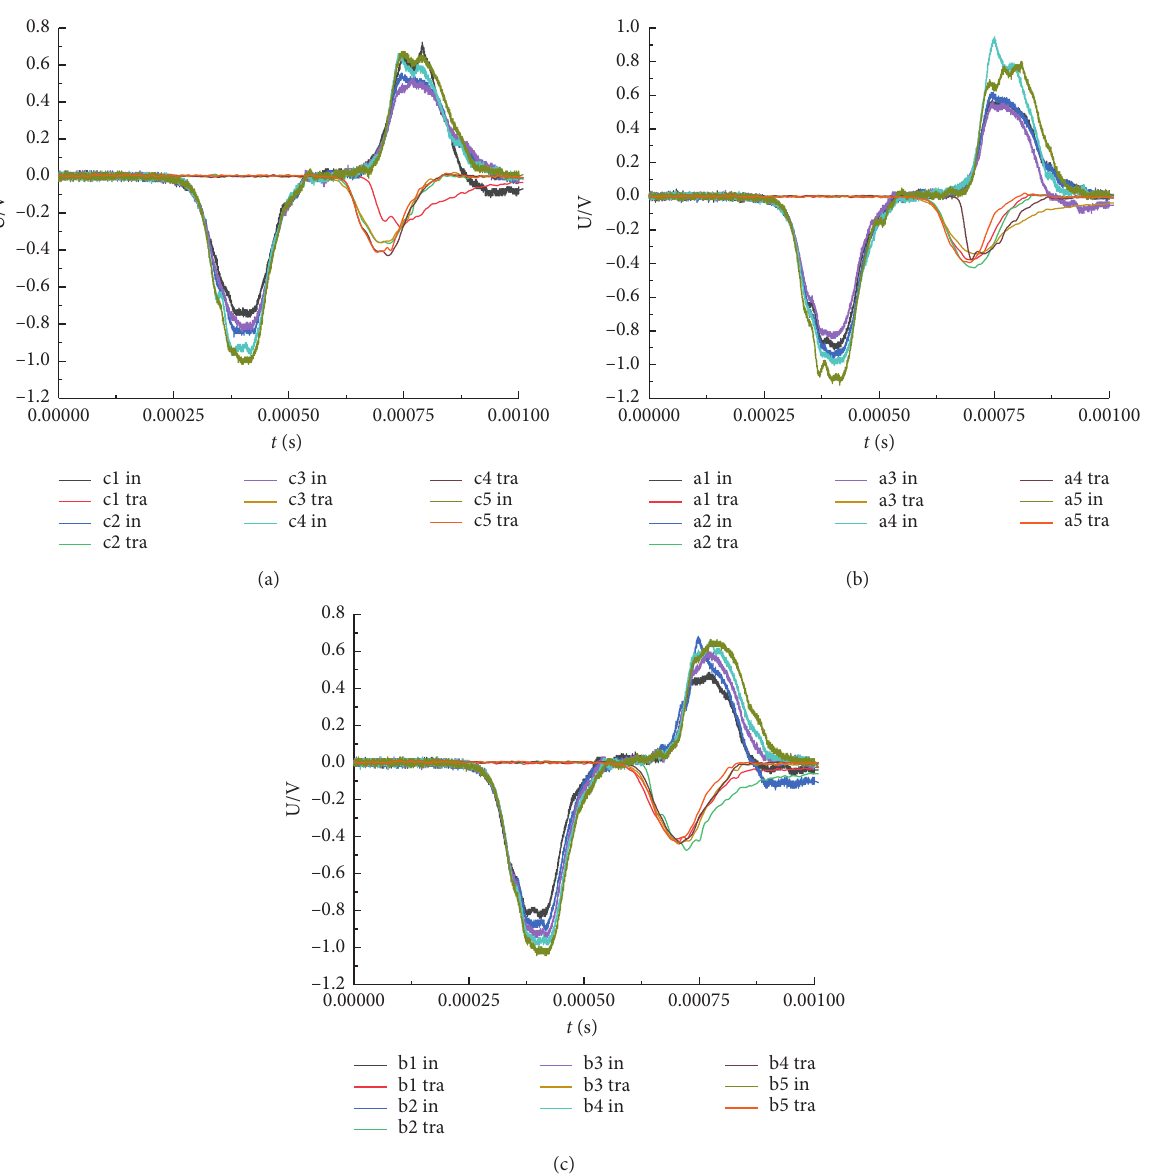
Figure 5: Waveform signal of specimens. (a) 0 ° . (b) 45 ° . (c) 90 °